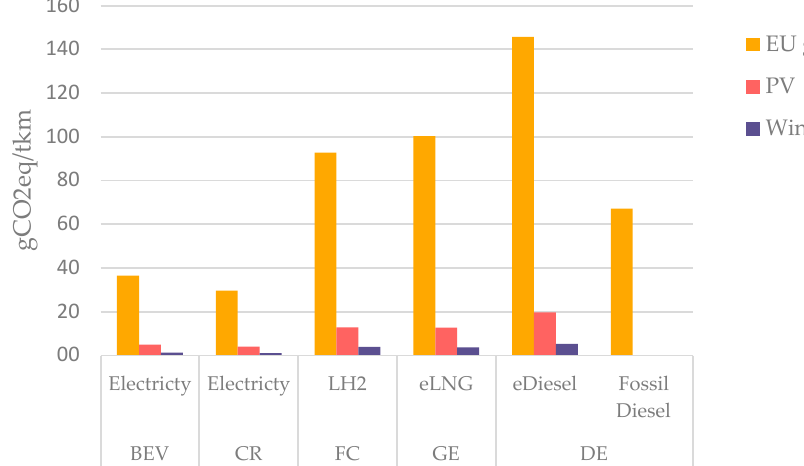
Figure 2. WTW results for the investigated fuel–powertrains options. The effect of the CI of the electricity used for the various pathways is reported in Figure 3. The bars represent the variability that can be observed in the EU27 member states, with the purple line being the value corresponding to the EU27 grid mix. Table 7. Perceptual GHG saving for the selected fuel–powertrains couples.